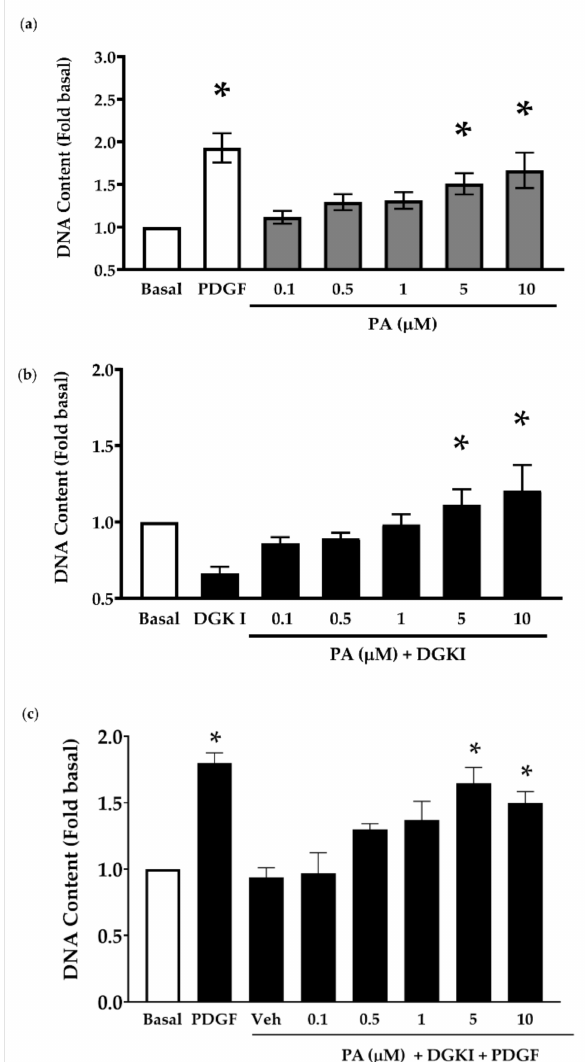
Figure 2. Effect of phosphatidic acid (PA) on ASM cell proliferation. ( a ) Human ASM cells were stimulated with PA (0.1 µ M–10 µ M) alone, ( b ) in the presence of DGKI (15 µ M), or ( c ) in the presence of DGKI (15 µ M) plus PDGF (10 ng/mL) for 72 h. Cell proliferation was evaluated using CyQuant assay and data normalized to basal condition. ( a , c ) Treatment with PDGF (10 ng/mL) was used as a positive control. Data above are mean ± SEM from n = 3–6 independent donors. * p < 0.05 compared to ( a , c ) basal or ( b ) DGKI using one-way ANOVA with Bonferroni post-hoc analysis. PA: Phosphatidic